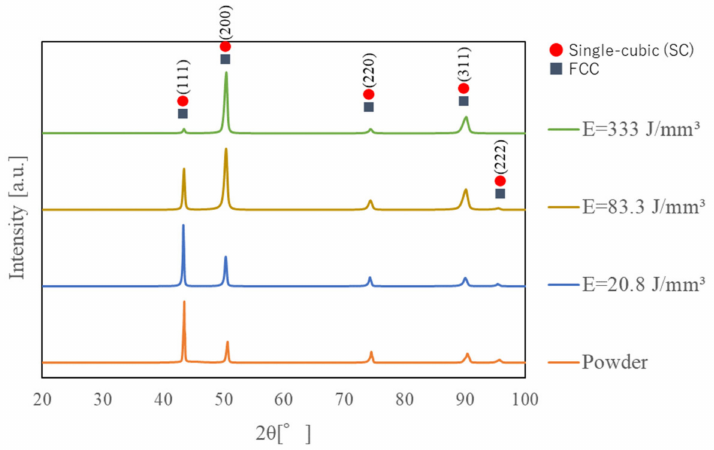
Figure 10. XRD patterns of the as-built specimens fabricated at various energy densities.